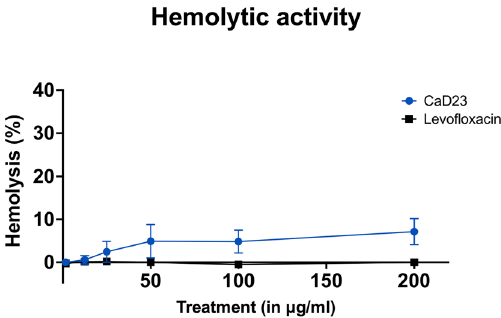
Figure 2. Hemolytic effect of CaD23 and levofloxacin (a commonly used antibiotic for bacterial keratitis) in various concentrations against fresh human erythrocytes, determined after 1 h of treatment. Percentage hemolysis is presented as mean ± standard deviation (depicted in error bars) of two independent experiments performed in biological duplicate. Some error bars are missing due to small standard deviation values. The graph demonstrating minimal hemolytic effect of CaD23 against fresh human erythrocytes (only 7.1 ± 3.0% at 200